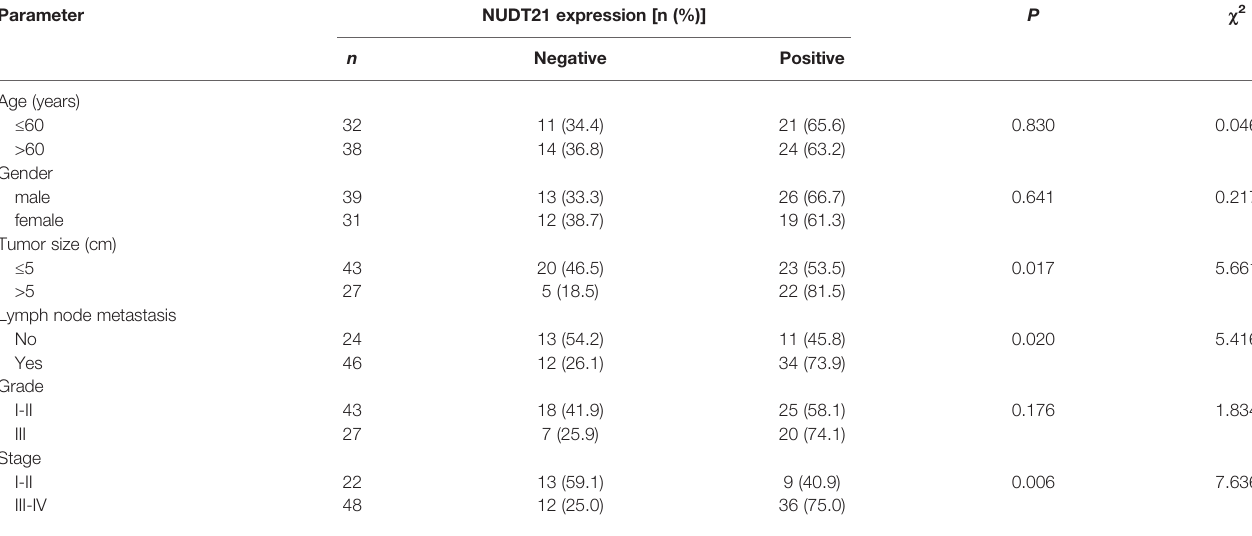
TABLE 1 | Association of NUDT21 expression with clinicopathological features in gastric cancer patients. Parameter NUDT21 expression [n